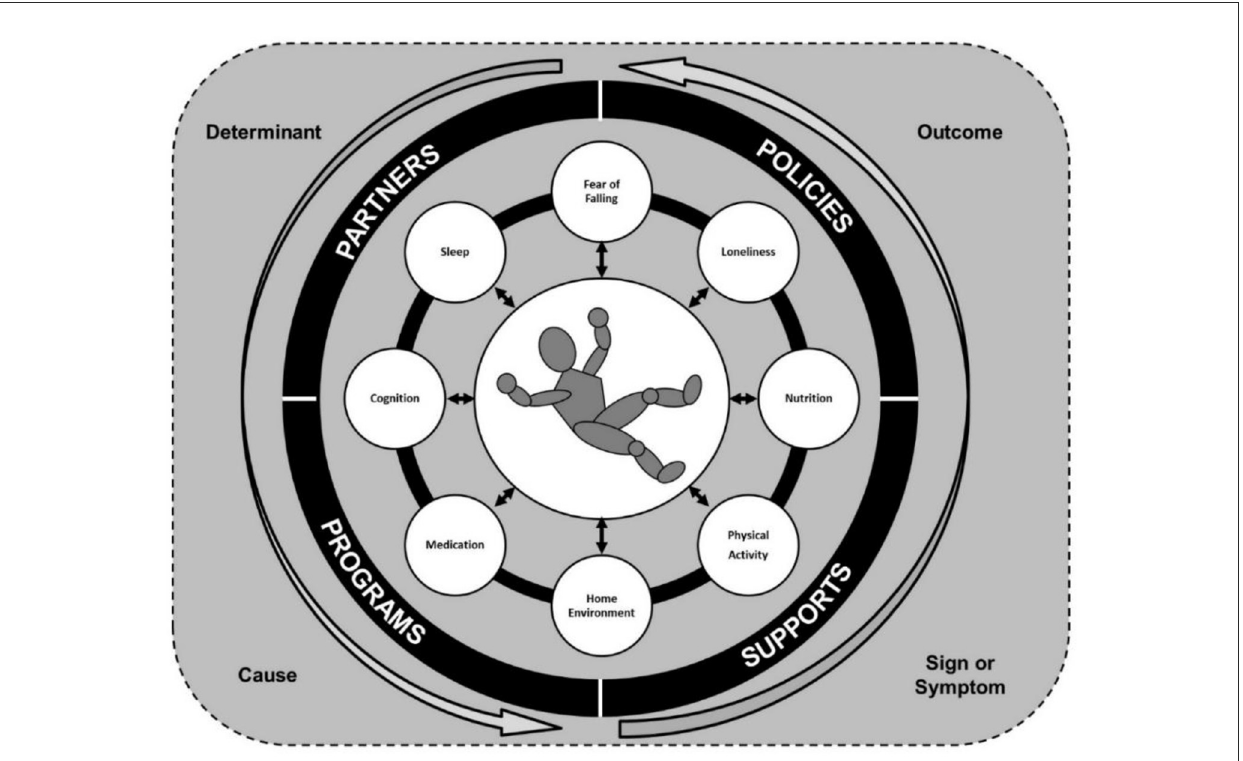
FIGURE1 Falls as a multi-directional risk among older